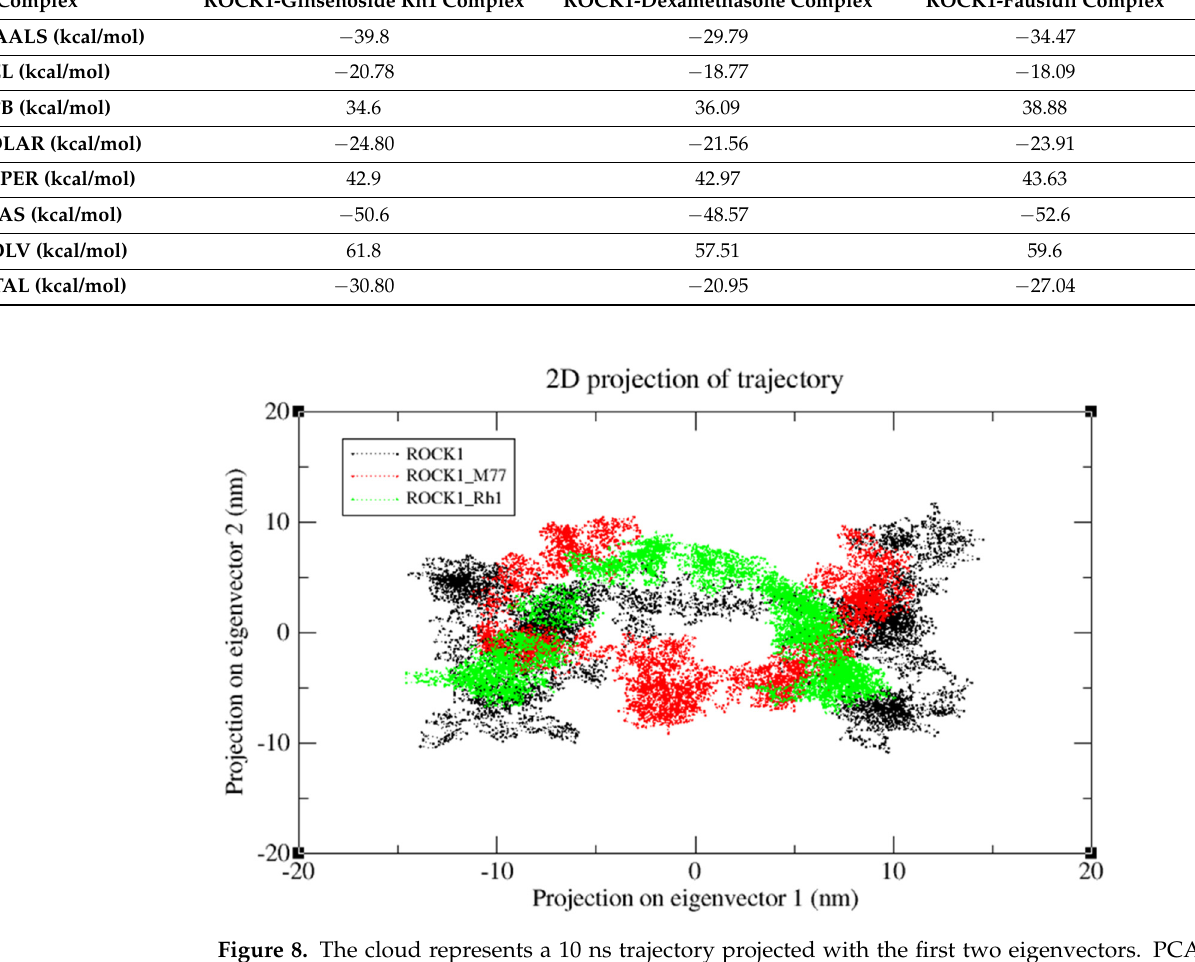
Table 5. Calculated binding free energy (MM-PBSA).